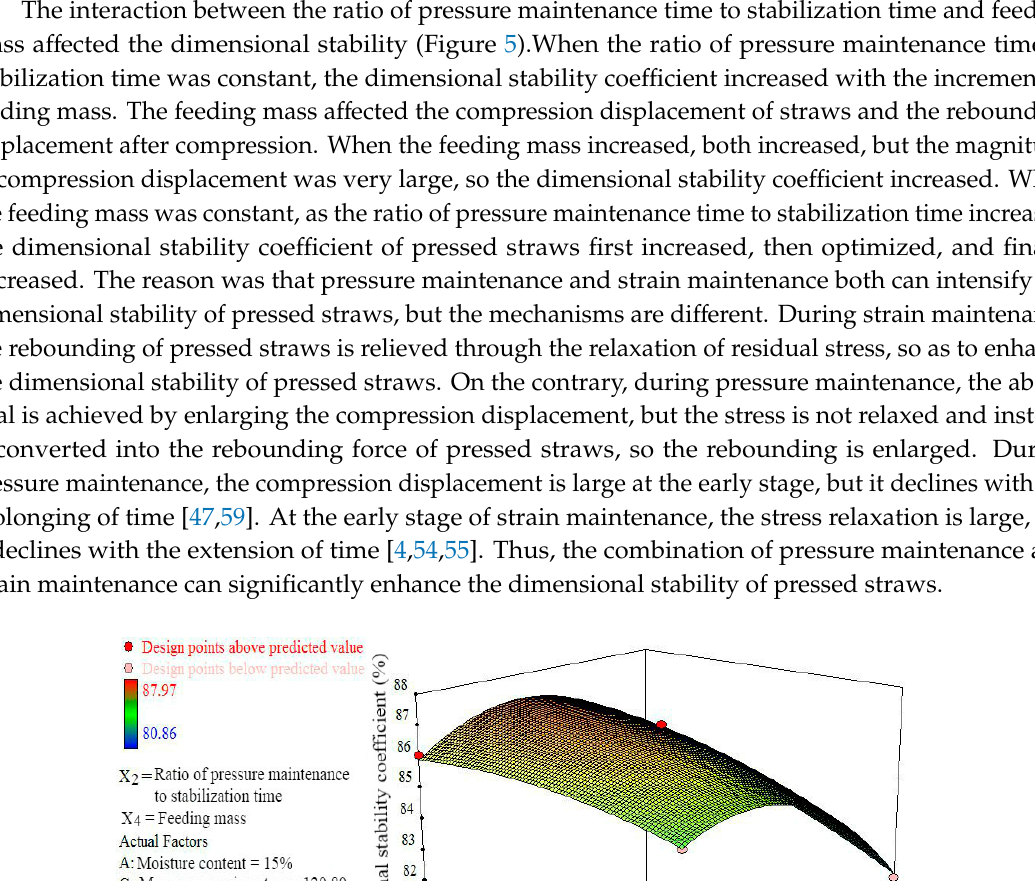
Figure 4. Effects of moisture content and max compression stress on relaxation density (ratio of pressure maintenance to stabilization time of 0.5 and feeding mass of 3 kg).